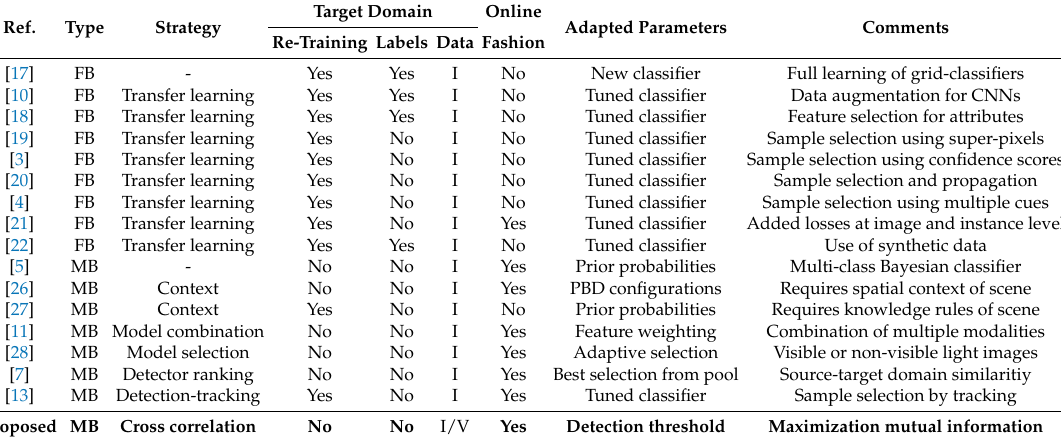
Table 1. Comparison between the main reviewed approaches for adapting people detectors. FB, feature-based approaches; MD, model-based approaches; PBD, part-based detector; I, image; V, video.